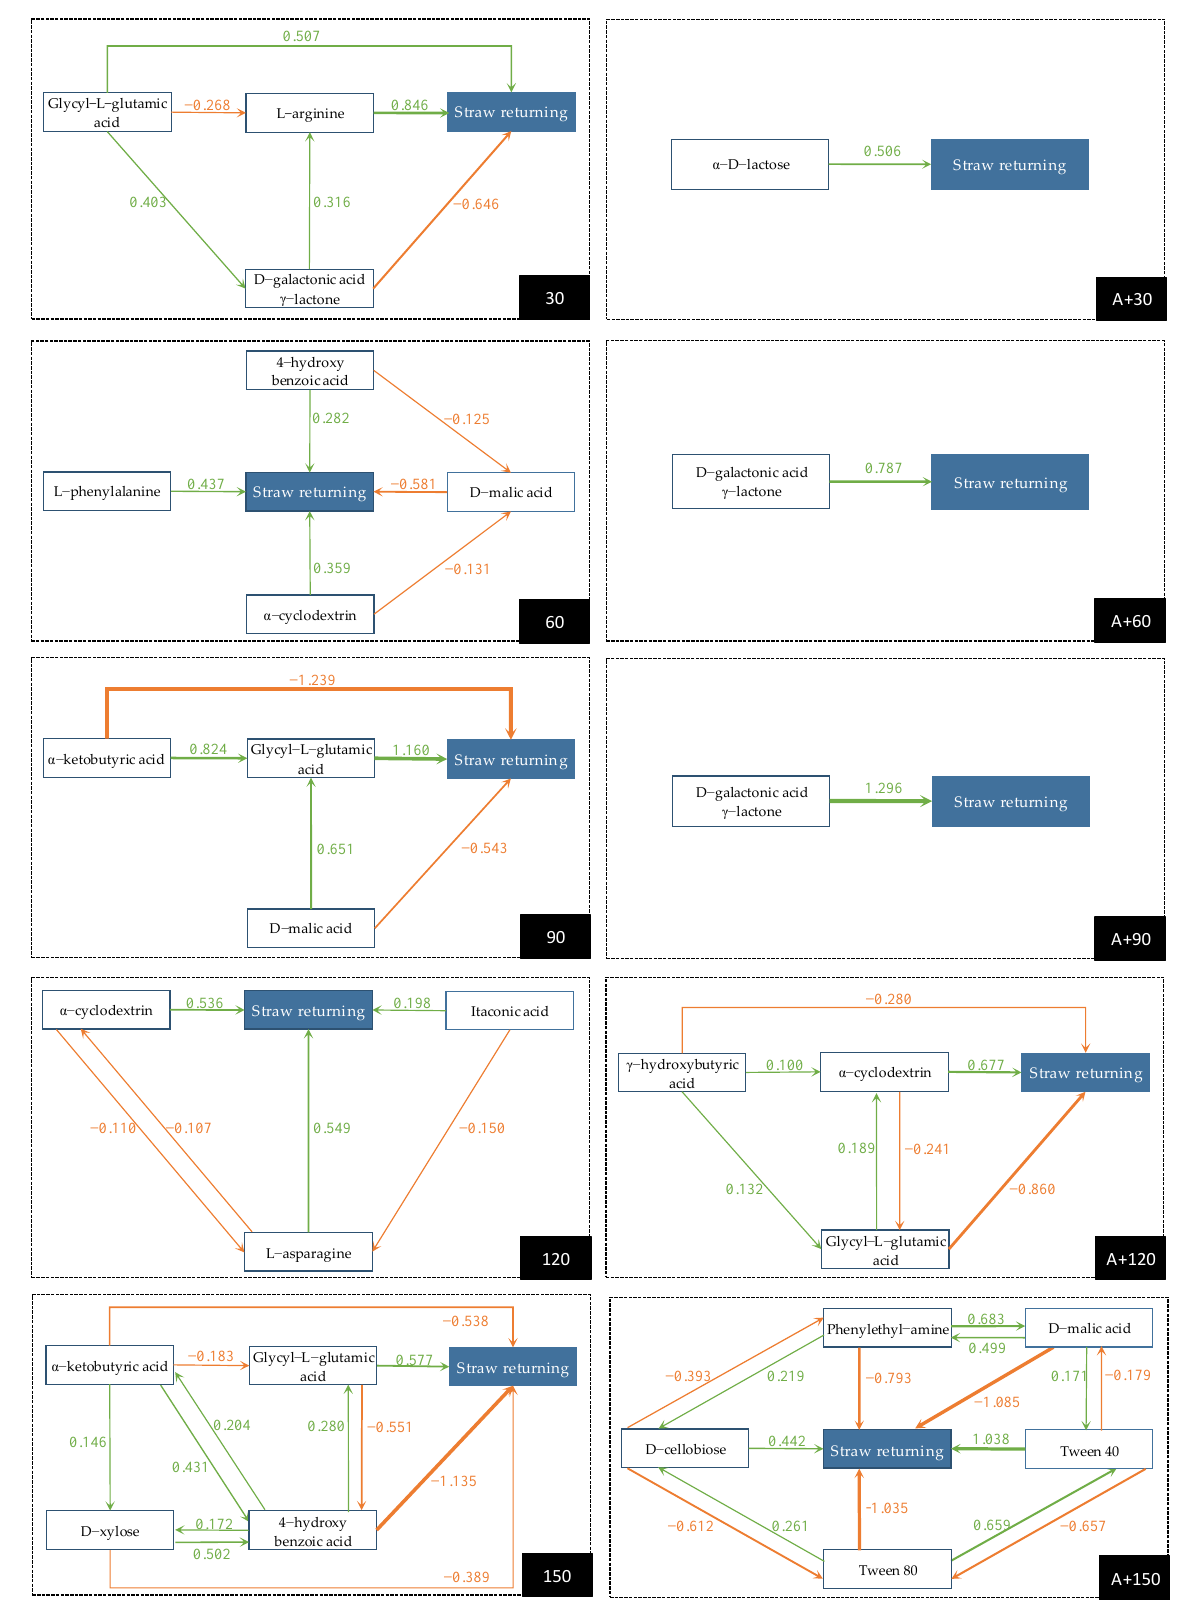
Figure 3. Path diagram.